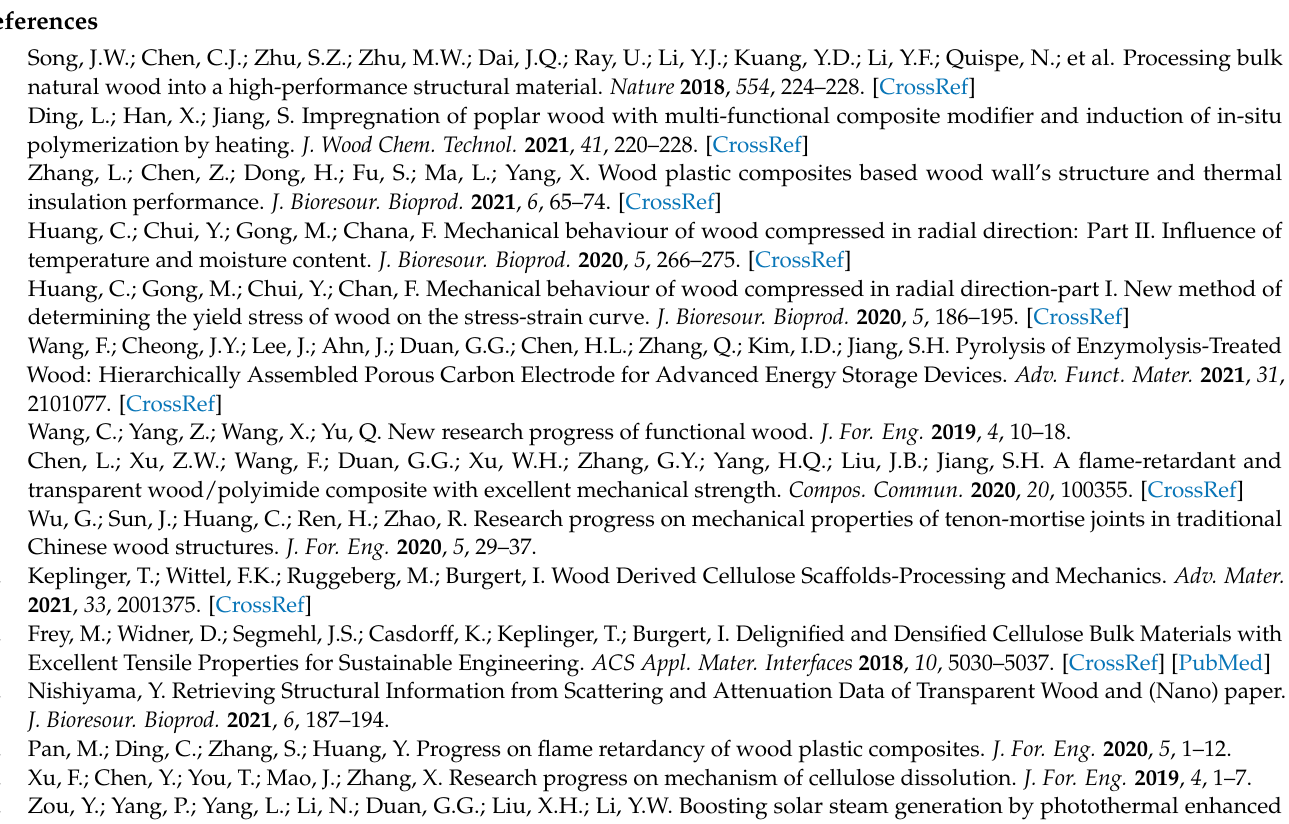
ment, Figure S3: SEM images of NW, Figure S4: SEM transverse images of CS AD , Figure S5: SEM longitudinal images of CS AD , Figure S6: SEM transverse images of CCS AD-ANF (a, b) and SEM longitudinal images of CCS AD-ANF (c, d), Figure S7: Magnified FTIR spectra for CS and CCS AD-ANF